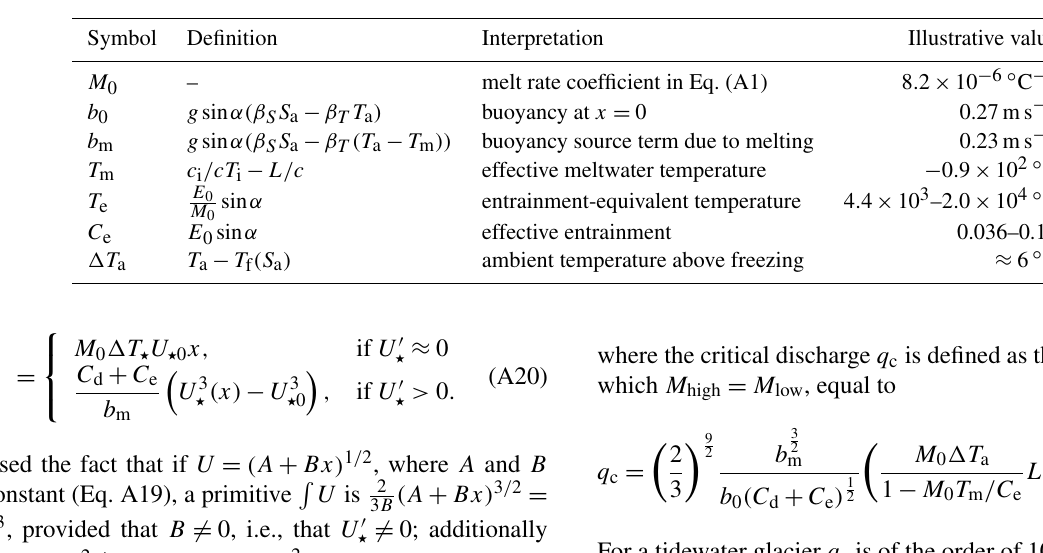
Table A1. Summary of Appendix variables. Illustrative value provided for T i = − 10 ◦ C, T a = 4 ◦ C, S a = 34 . 65psu, sin α = 1 (tidewater glacier) and range for E 0 = 0 . 036 − 0 .